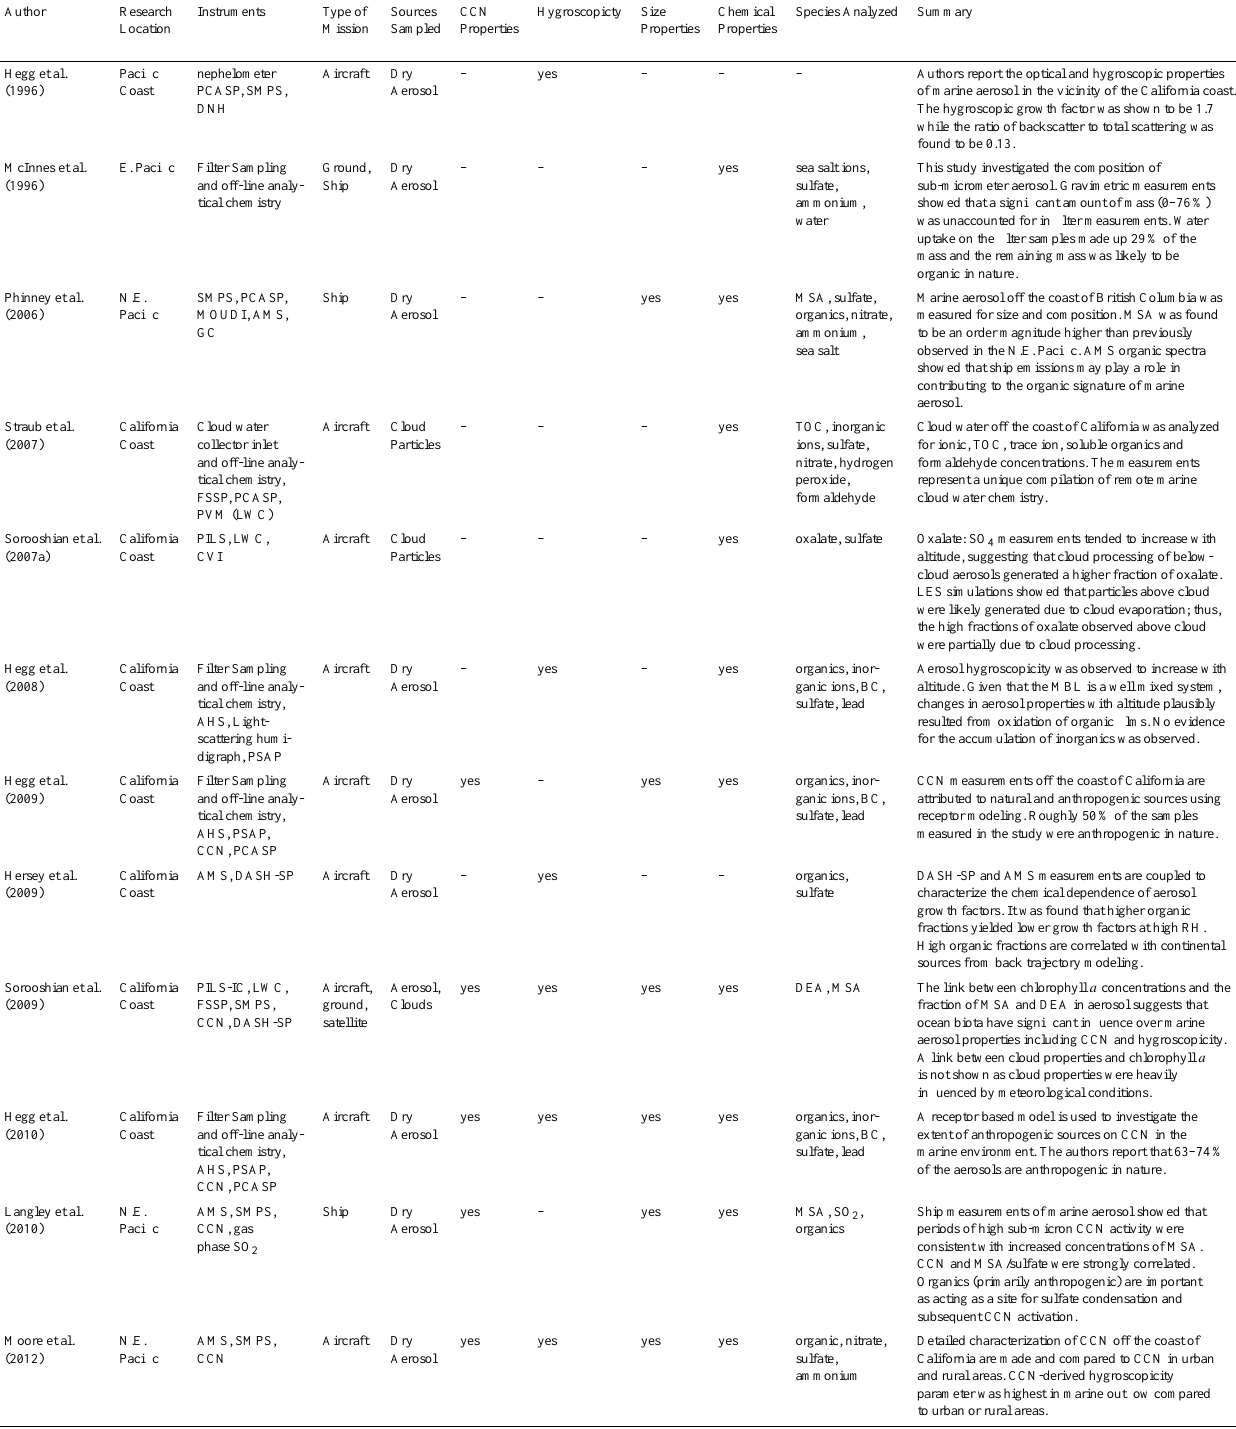
Table 1. Previous studies on the properties of marine aerosol over the Northeastern Pacific Ocean. Footnotes define instrument